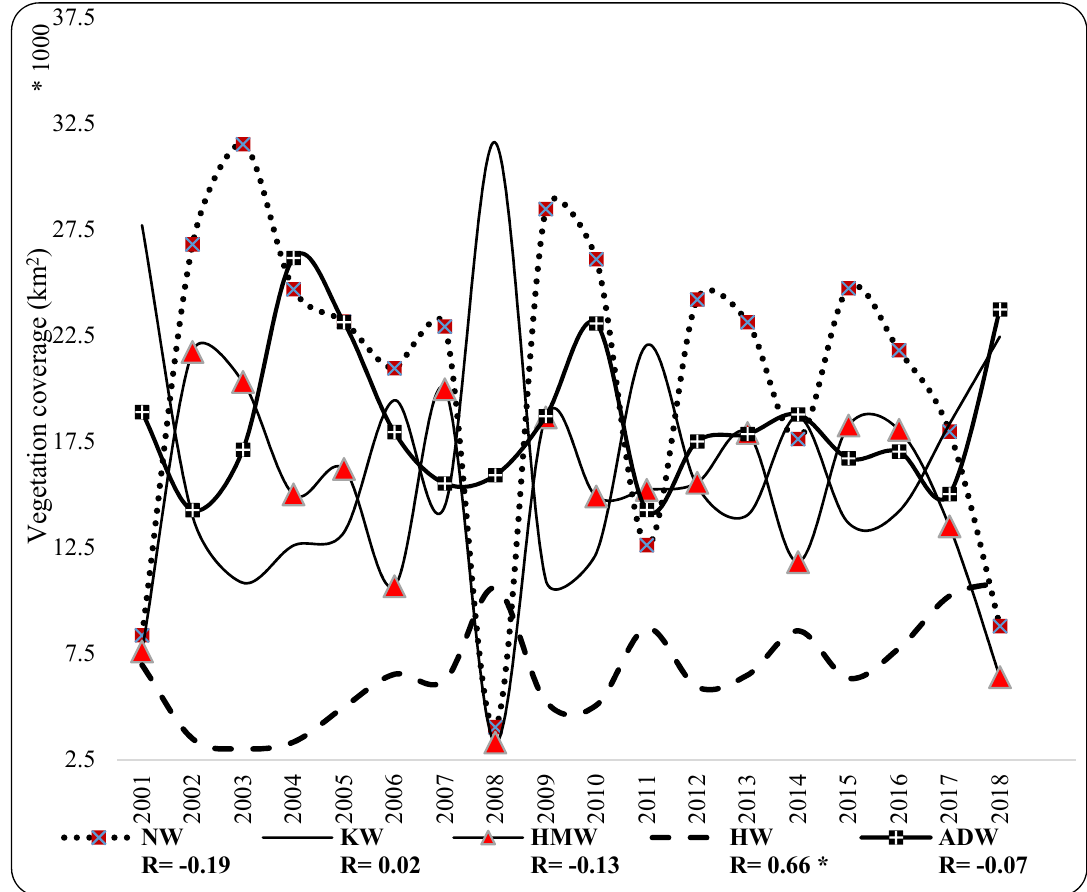
Figure 8. Time series and trend of vegetation coverage of each watershed in Afghanistan between 2001 and 2018 (* denotes significance level at p = 0.05).